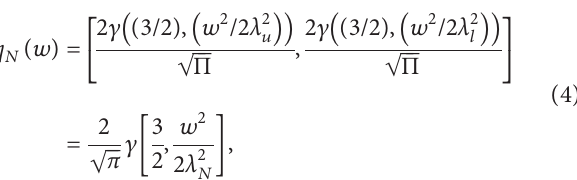
Figure 1: Density plots of the NMD at different values of the neutrosophic parameter. (a) λ (d) λ N � ( 5 , 6 )